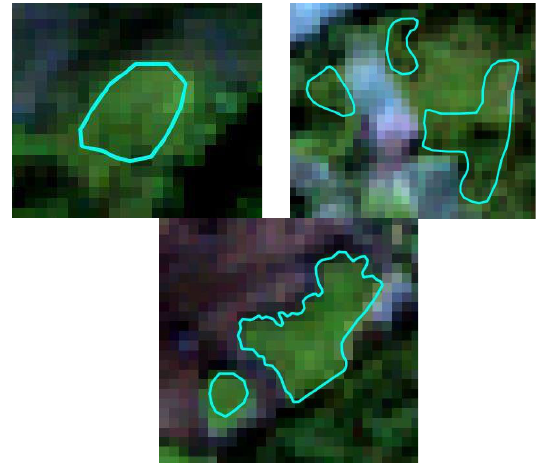
Figure 7 ROIs used for training in the classification. The ROIs are overlaid on a composition of Sentinel 2 L2A bands 3-2-1.